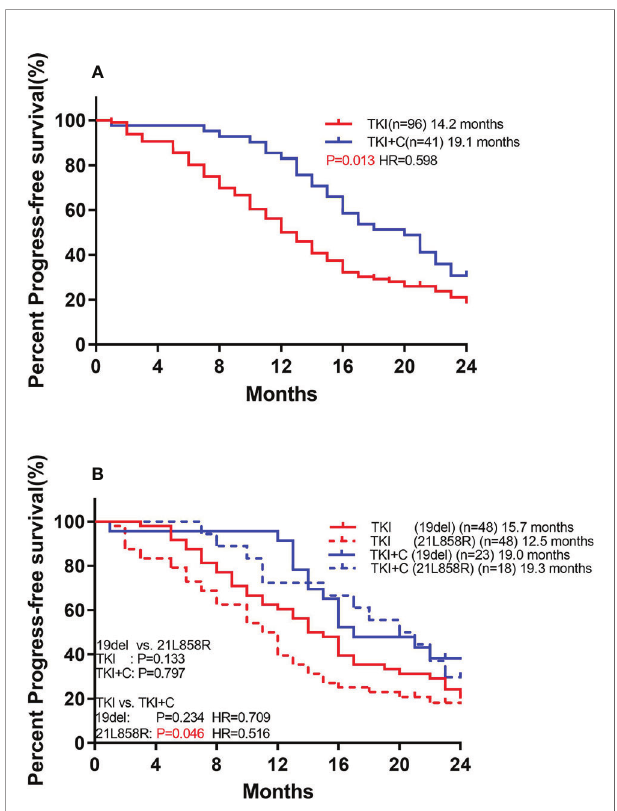
FIGURE 3 | (A) Comparison of monotherapy and combination therapy for PFS in patients with EGFR mutation. (B) Comparison of association of EGFR subtype with PFS to monotherapy and combination therapy in patients with EGFR